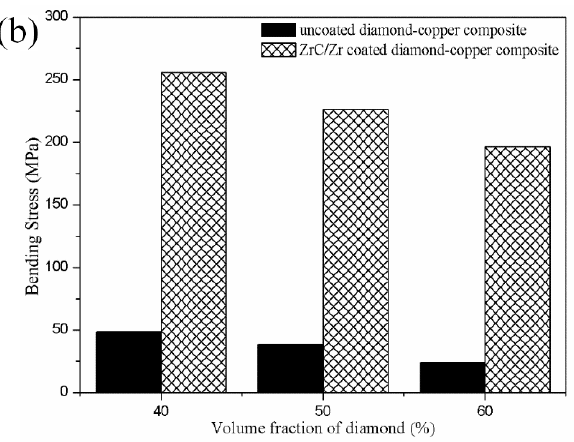
Figure 8. ( a ) Bending stress-deflection curves of diamond-copper composites; ( b ) bending strength of uncoated and ZrC/Zr-coated diamond-copper composites.